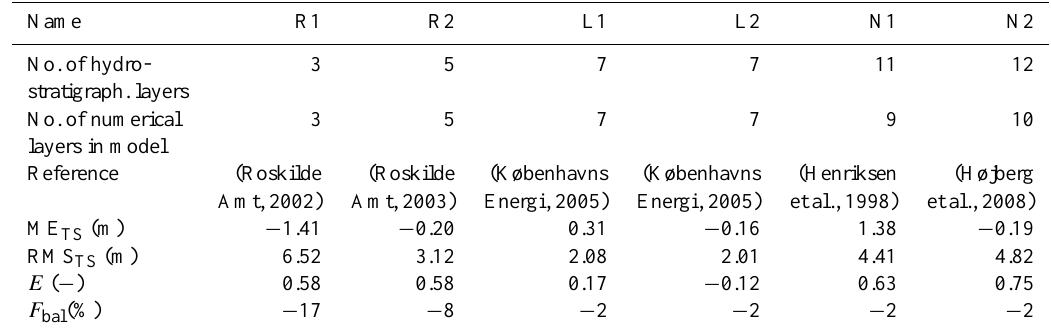
Table 1. Geological models of the Langvad Stream catchment area. Calibration statistics are indicated by the mean error (ME TS ) and root mean square error of hydraulic head time series (RMS TS ) , the Nash–Sutcliffe coefficient ( E ) and the water balance ( F bal ) for stream discharge.